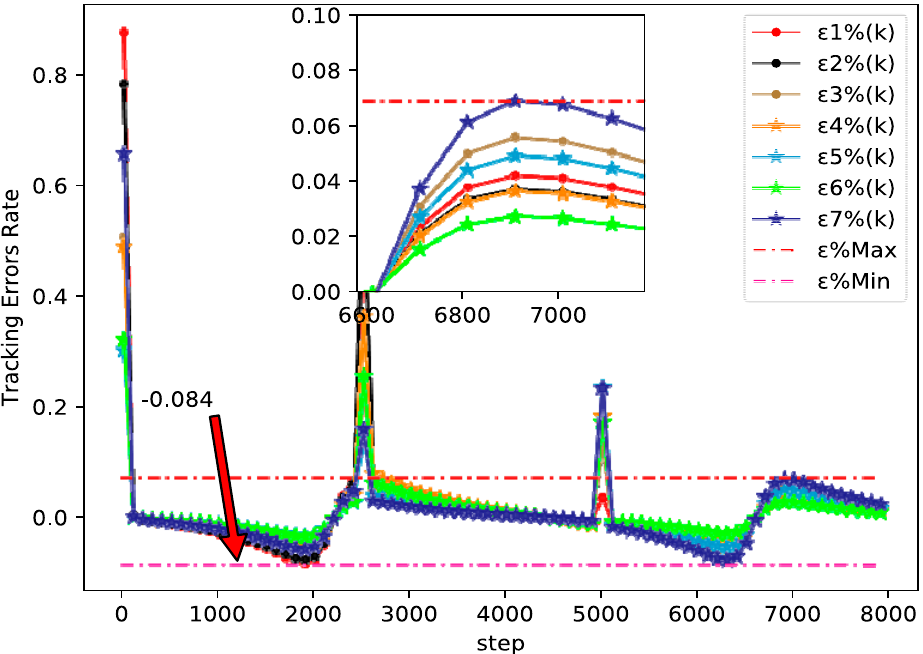
Figure 7. Tracking errors rate of each agent at Q = 2200 (example 2).